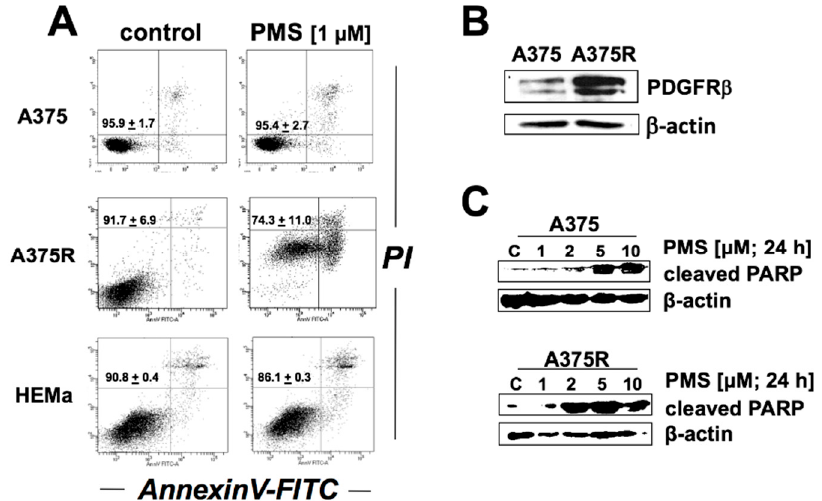
Figure 6. PMS treatment preferentially impairs viability of vemurafenib-resistant human malignant melanoma cells with induction of caspase-dependent PARP-cleavage. ( A ) Differential cytotoxicity of PMS (1 µ M; 24 h) was examined in a focused panel of cultured human malignant melanoma cells (A375, A375R (vemurafenib-resistant A375)) and primary melanocytes (HEMa) using flow cytometric